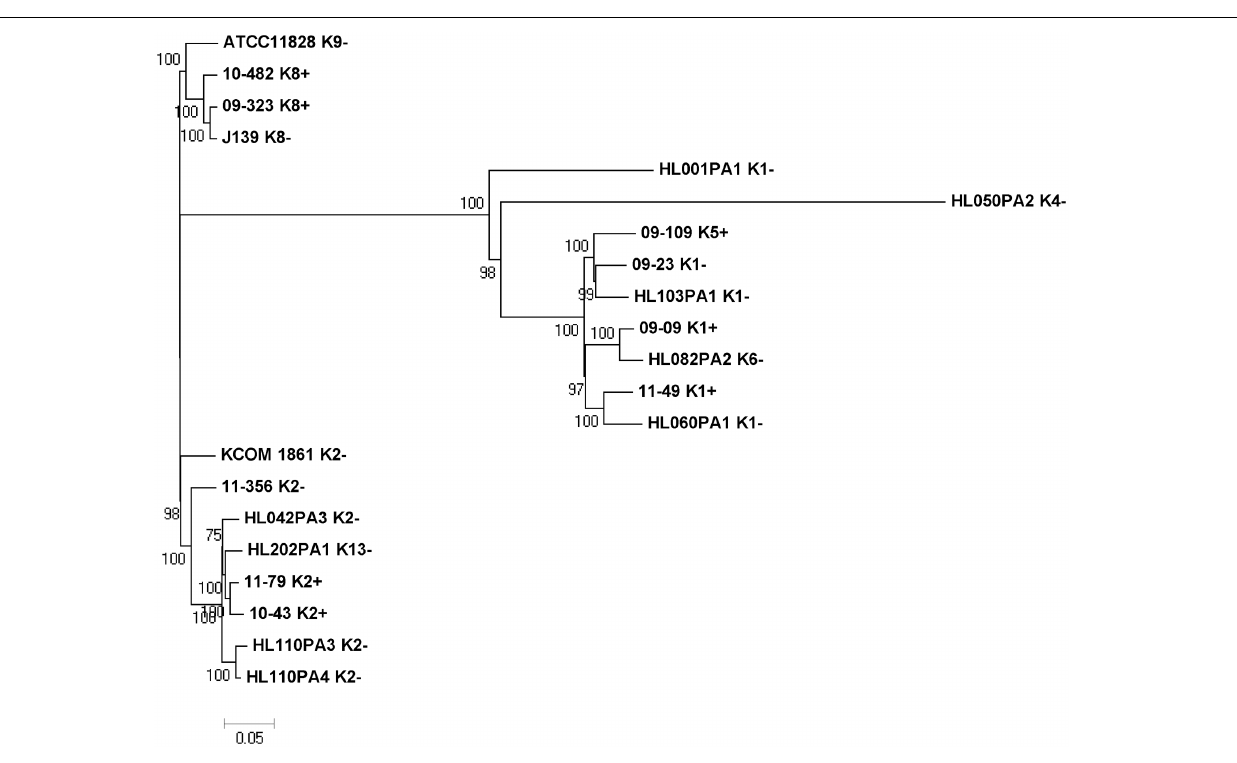
FIGURE 5 | Phylogenomic comparison of strains of C. acnes subsp. defendens. The genomes of all nine newly sequenced type II strains and the available 12 type II genomes deposited in public databases (GenBank) were compared using the CSI phylogeny program. The phylogenetic analysis is based on the concatenated alignment of high quality SNPs. The SLST type (K type) of each strain is given after the strain name. Three main clades are identified, constituting of K8/K9, K2/K13 and K1/K4/K5/K6 strains,